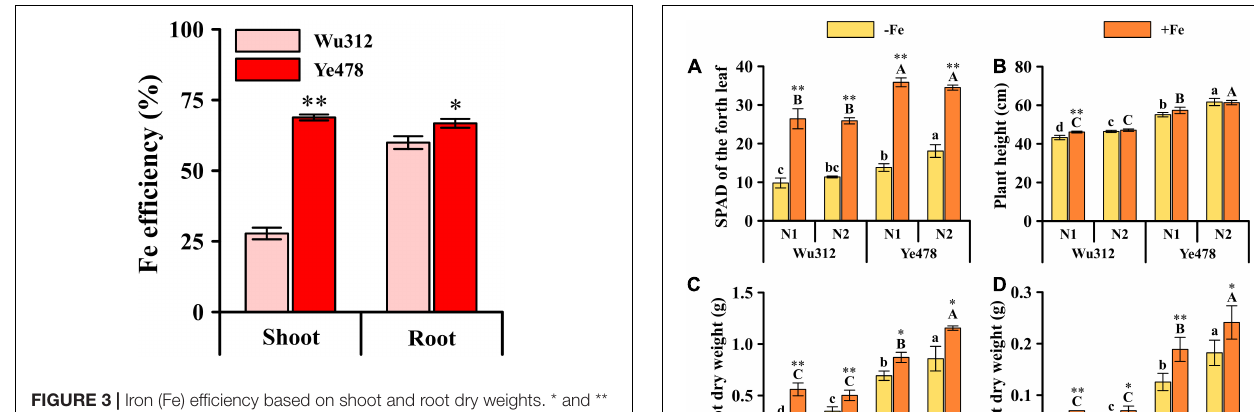
FIGURE 3 | Iron (Fe) efficiency based on shoot and root dry weights. * and ** indicate significant difference between the Fe-inefficient (Wu312) and Fe-efficient (Ye478) inbred lines at p < 0.05 and p < 0.01, respectively.